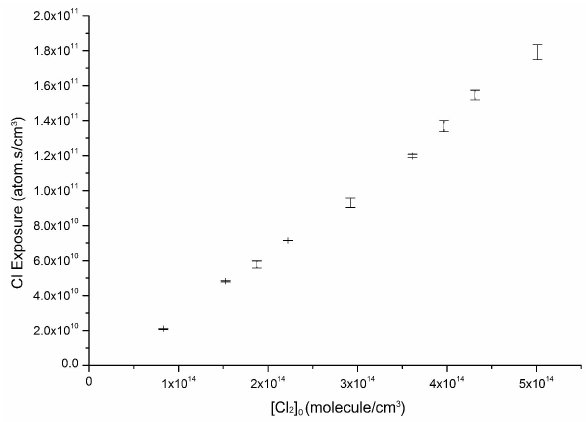
Figure 2. Chlorine exposure as a function of the initial Cl 2 concentration in the reactor; Q tot = 2 Fig. 2. Chlorine exposure as a function of the initial Cl 2 concen- tration in the reactor. Q tot = 4 . 0Lmin − 1 and eight UV lamps are 4.0 L min -1 and 8 UV lamps powered. Errors bars express the minimum and maximum values 3 powered. Error bars express the minimum and maximum values of of 4 experiments. 4 four